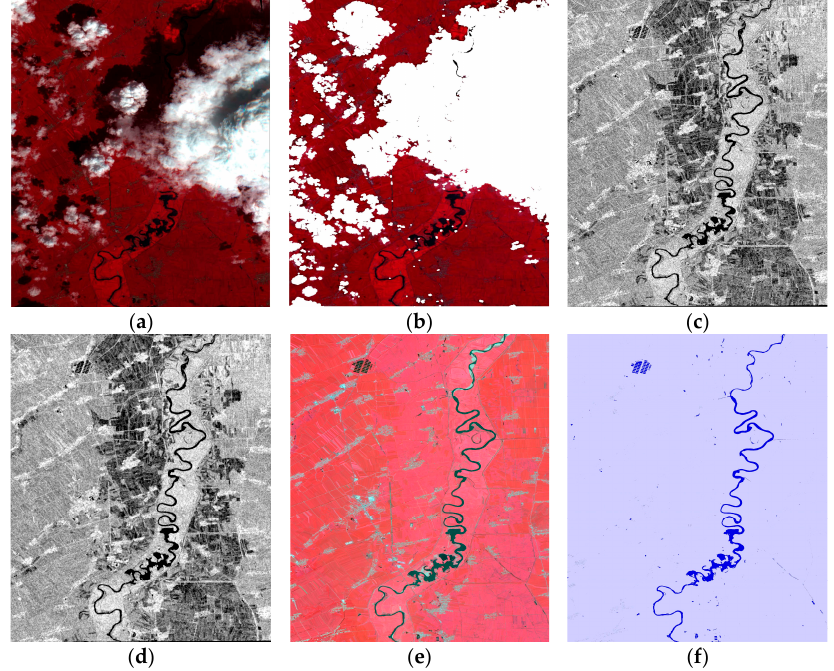
Remote Sens. 2022 , 14 , x FOR PEER REVIEW